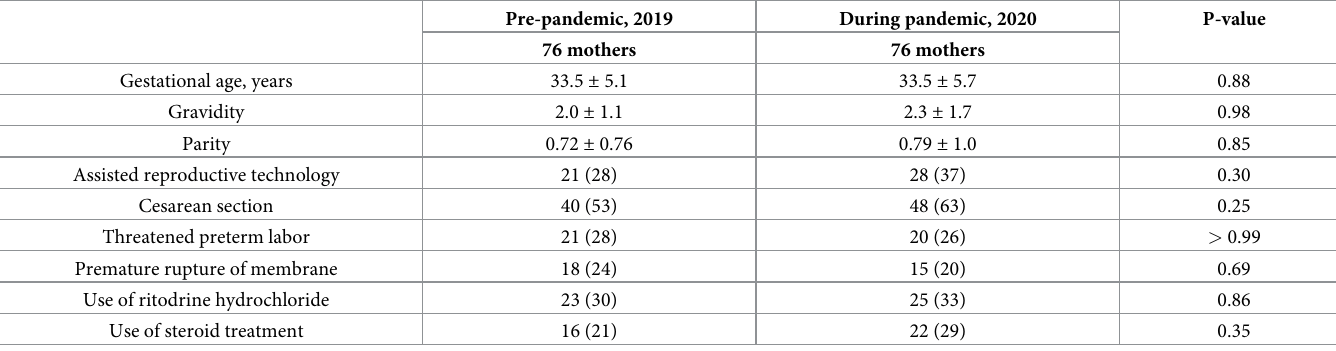
Table 2. Baseline characteristics of mothers in this